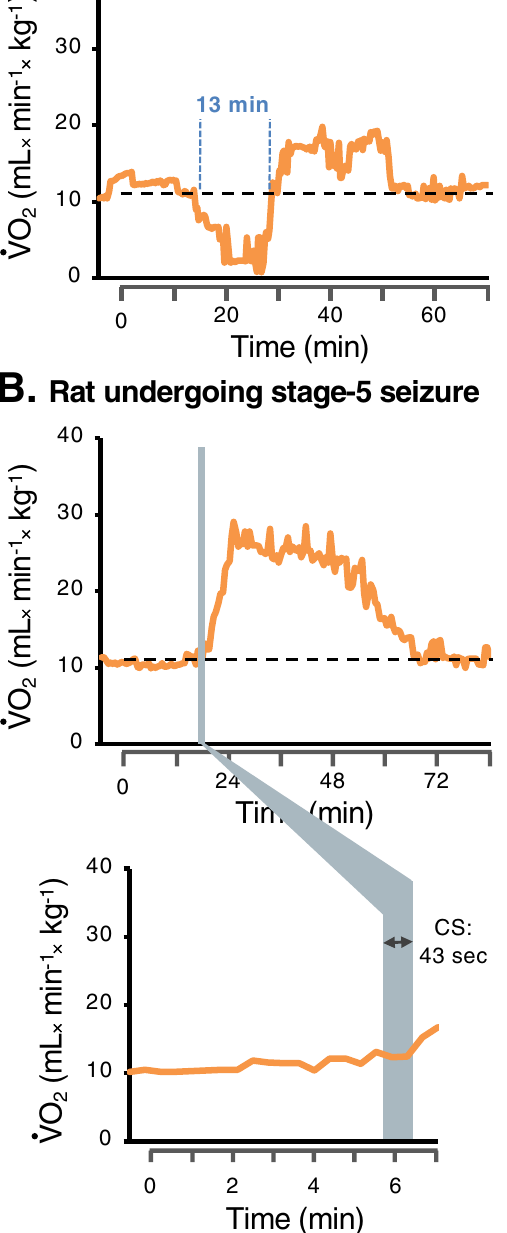
Figure 2. SDOC can occur independently of behavioral spontaneous seizures. ( A ) Example of an SDOC event recorded in an EPI rat at 5 weeks post-SE, when it was adopting a sleep posture. This SDOC event occurred during the light period and was identified with the decline in ⩒ O 2 values. No behavioral seizure was observed before, during, and after SDOC occurrence. In contrast, ( B ) a sharp increase in ⩒ O 2 was observed after a 43-s stage-5 seizure according to Racine’s scale in an EPI/SDOC + rat with ⩒ O 2 levels over the pre-ictal level for approximately 30